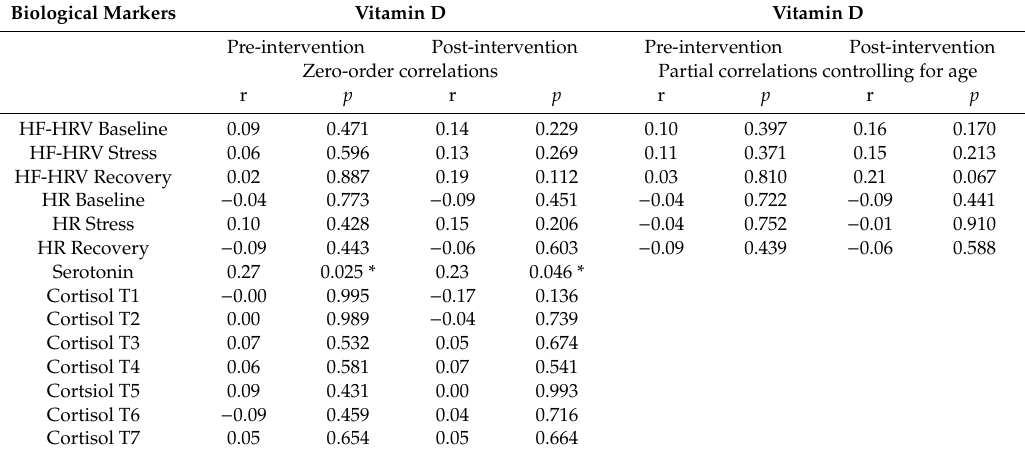
Table 3. Shows correlations between vitamin D and biological markers of stress responses pre- and post-intervention. Biological Markers Vitamin D Vitamin D Pre-intervention Post-intervention Pre-intervention Post-intervention Zero-order correlations Partial correlations controlling for age